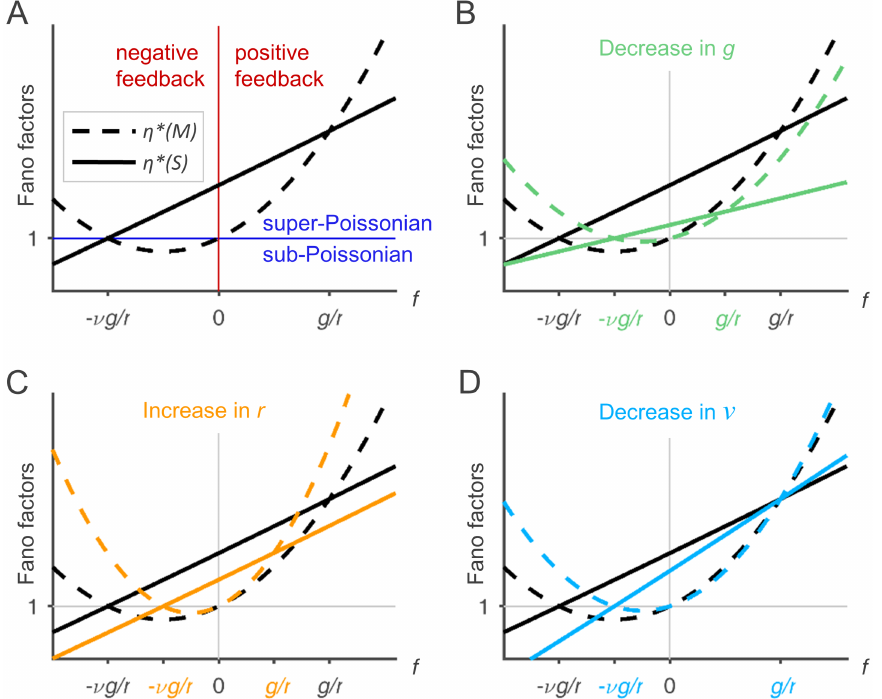
Fig 3. Results of the linear noise approximation. The plots show the dependence of η (cid:3) ( M ) (dashed line) and η (cid:3) ( S ) (solid line) on f with fixed values of g , r , and ν . In panels (B) to (D), parameters g , r and ν are varied (colored lines) in order to illustrate their effect on the noise of the system. The parameters are as follows: (A): g = 1, r = 100, ν = 1; (B): g is halved compared to (A), i.e. g = 0.5, r = 100, ν = 1; (C): r is doubled compared to (A), i.e. g = 1, r = 200, ν = 1; (D): ν is halved compared to (A), i.e. g = 1, r = 100, ν = 0.5.